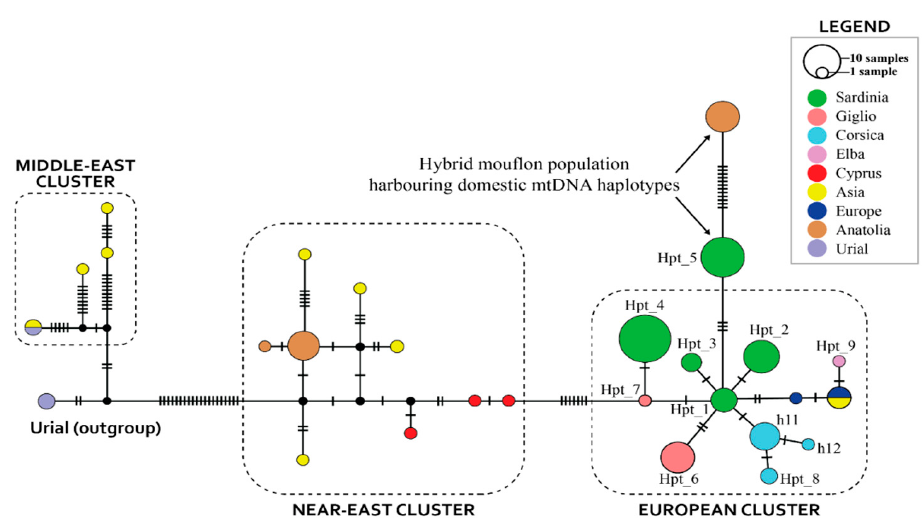
Figure 2. Median-joining network showing the relationship among mouflon mtDNA haplotypes.